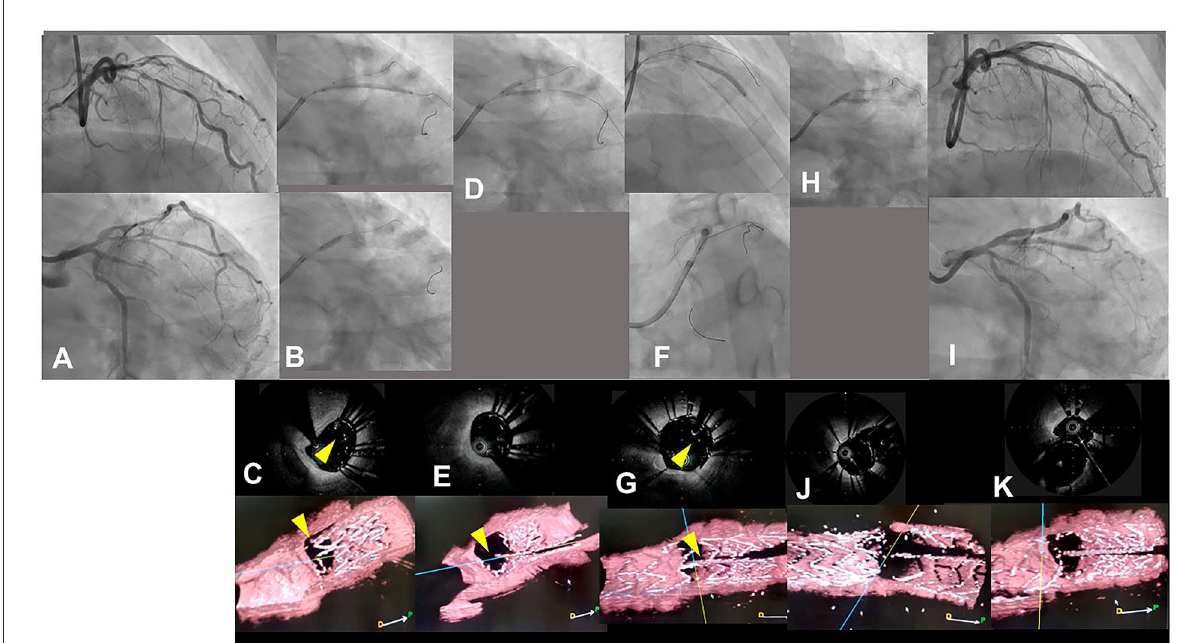
FIGURE7 Assessment of guidewire recrossing point in double kissing (DK)-crush stenting with three-dimensional optical coherence frequency-domain imaging (OFDI). A 68-year-old man with Medina 0-1-1 lesion in left anterior descending artery (LAD)-diagonal bifurcation (A) (Supplementary Movie 9) was treated with DK-crush stenting. After a Ultimaster 2.25/38mm stent was implanted in diffusely diseased diagonal branch with 3mm protruded into the LAD ( B top panel), a 3.0mm balloon placed in the LAD crushed the proximal site of the side branch stent ( B bottom panel). The guidewire recrossed inside the crushed stent, which is confirmed with two-dimensional and three-dimensional OFDI images ( C top and bottom panels, yellow arrowheads: guidewires) (Supplementary Movie 10). First kissing balloon inflation (KBI) using 3.0mm and 2.25mm balloons was performed (D) . Side branch stent is crushed more in the two-dimensional OFDI image ( E top panel) and side branch ostium is open wide in the three-dimensional image ( E bottom panel) (Supplementary Movie 10). Xience Alpine 2.5/28 and 3.0/23mm stents were implanted in the middle LAD and left main and proximal LAD, respectively ( F top and bottom panels). The OFDI image shows that the guidewire recrossed in the cell on the hole made by the first KBI ( G , yellow arrow) (Supplementary Movie 10). Second KBI was performed using 3.0 and 2.25mm balloons (H) . Final coronary angiography shows acceptable results (I) (Supplementary Movie 9) and OFDI images show adequate dilation in both branch ostia with minimal metallic carina ( J : pullback from LAD, K : pullback from diagonal branch) (Supplementary Movie